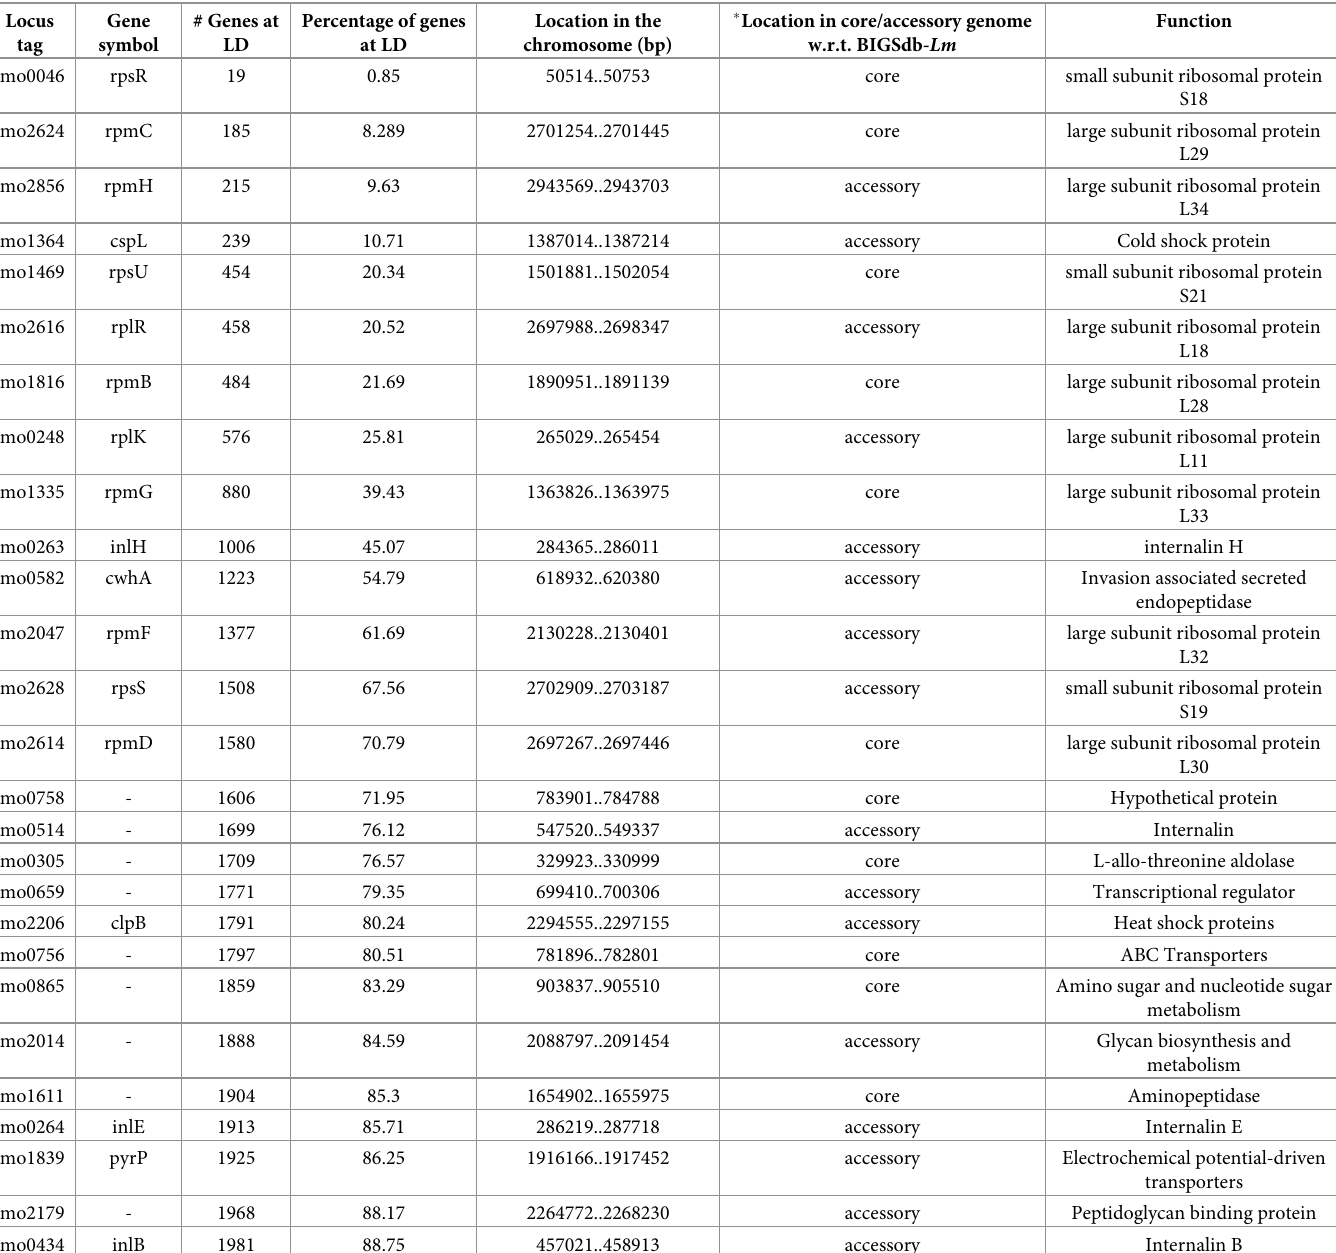
Table 2. Genes at LD with < 90% of genes in the genome of L . monocytogenes , showing significant evidence for horizontal genetic transfer. Locus Gene tag